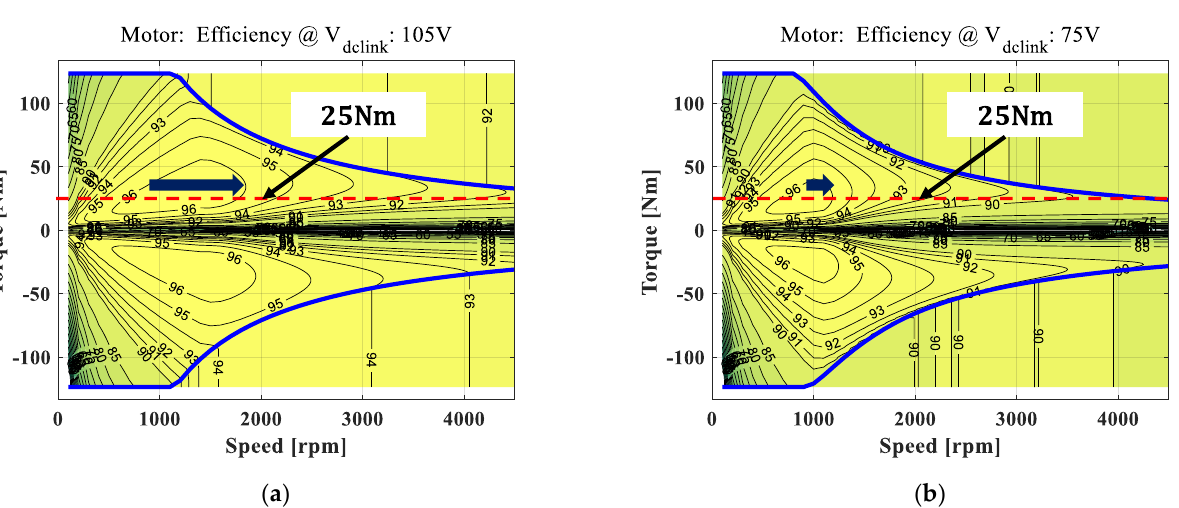
Figure 4. In-wheel motor model.